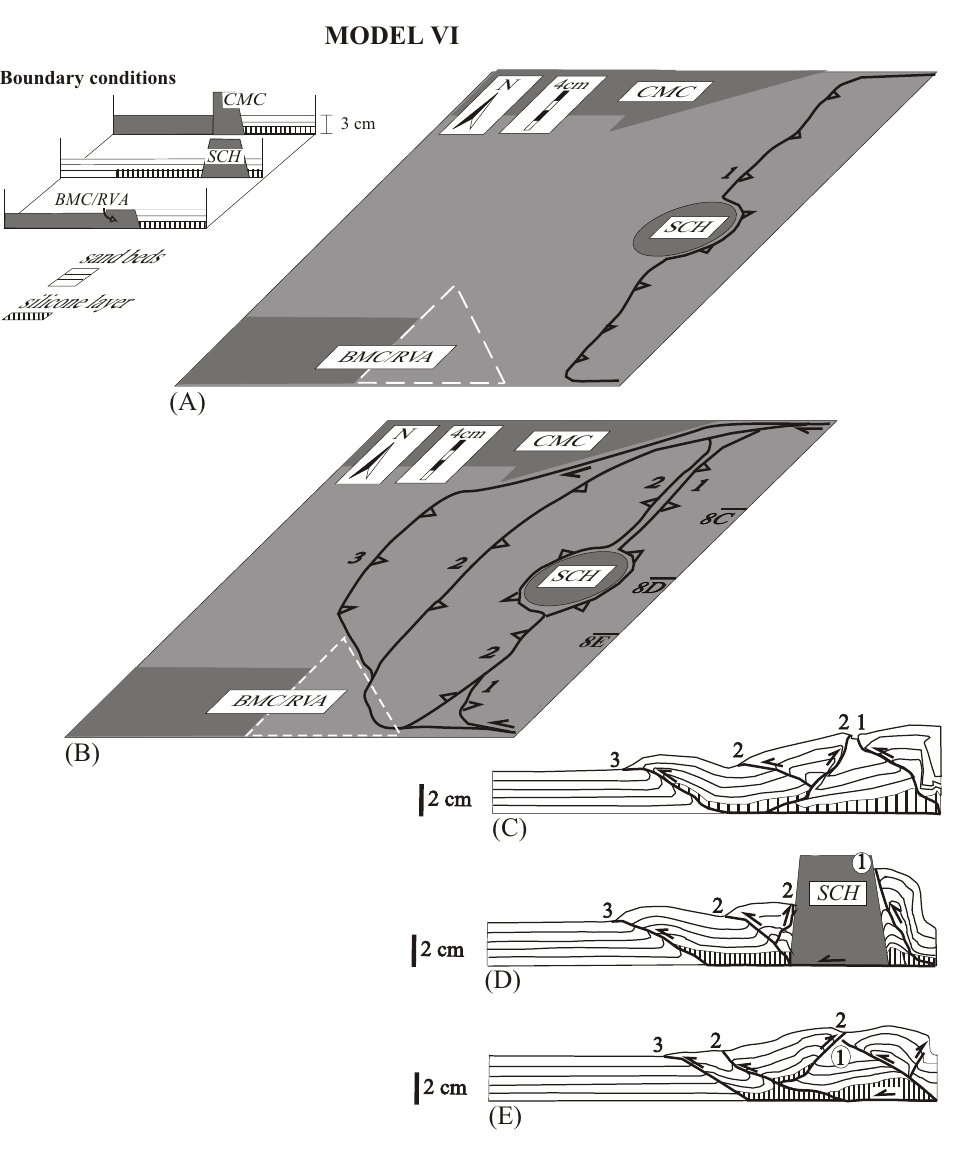
Fig. 8 – Plan-view and profile line drawings of model VI which simulates the Serra do Caraça structural high between two basement highs; the basal detachment is represented by a silicone layer. A and B – The model after 16% (6 cm) shortening with the Serra do Caraça structural high fixed, and after 30% (11 cm) shortening, respectively. In B, the position of the vertical sections are represented. C, D and E – Vertical sections showing thrusts and backthrusts. In D, note that fault 1 (representing theÁgua Quente Fault System) to the east of the Serra do Caraça structural high, appears nearly vertical. Numbers indicate the order of fault formation. SCH – Serra do Caraça structural high; CMC – Caetés Metamorphic Complex; BMC/RVA – Bação Metamorphic Complex/Rio das Velhas Arch.